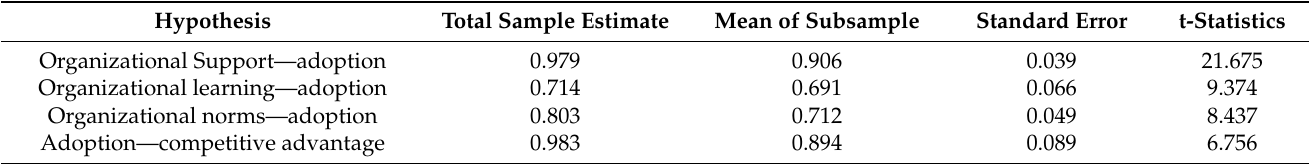
Table 6. Parameters of the structural